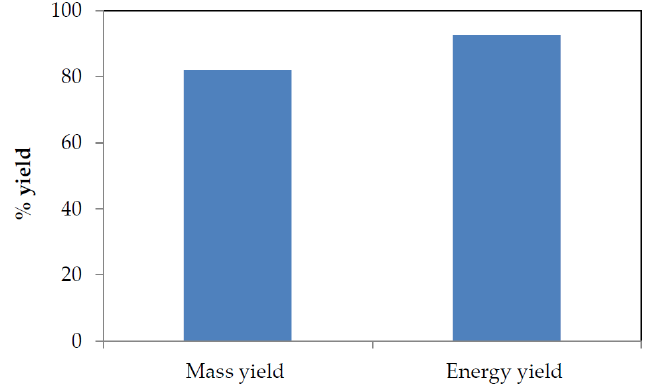
Figure 4. Mass and energy yield from SCB torrefied at 300 °C at a residence time of 5